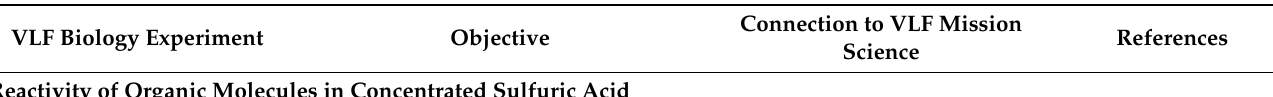
Table 2. Chemistry and biology experiments to inform Venus Life Finder (VLF) Mission science and instruments